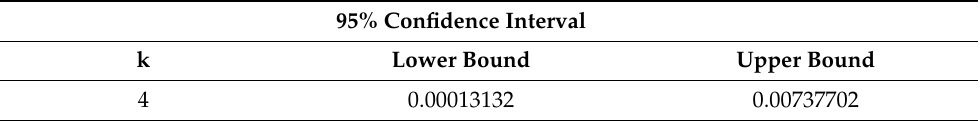
Table 3. Permutation test for